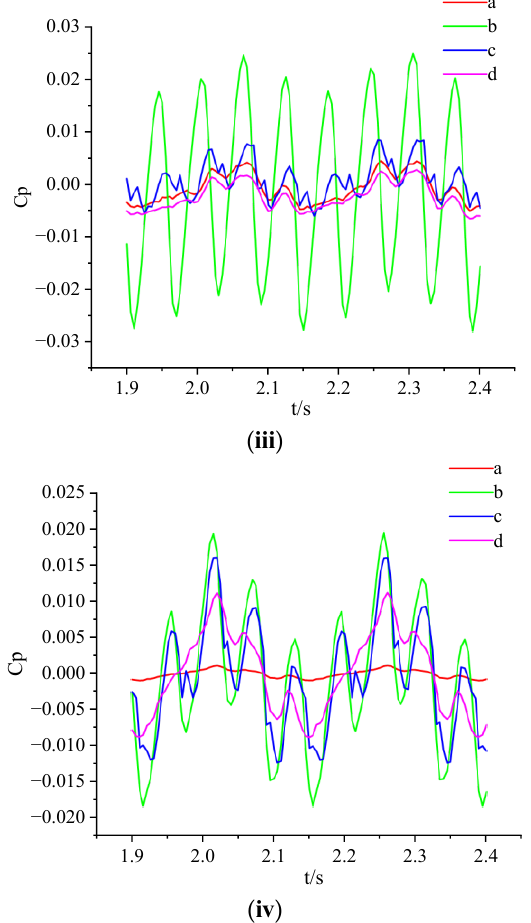
Figure 9 Time – domain diagram of the pressure pulsation under pump conditions. ( ⅰ ) 0.6Q. ( ⅱ ) Figure 9. Time–domain diagram of the pressure pulsation under pump conditions. ( i ) 0.6Q. ( ii ) 0.8Q. 0.8Q. ( ⅲ ) 1.0Q. ( ⅳ ) 1.2Q. ( iii ) 1.0Q. ( iv )